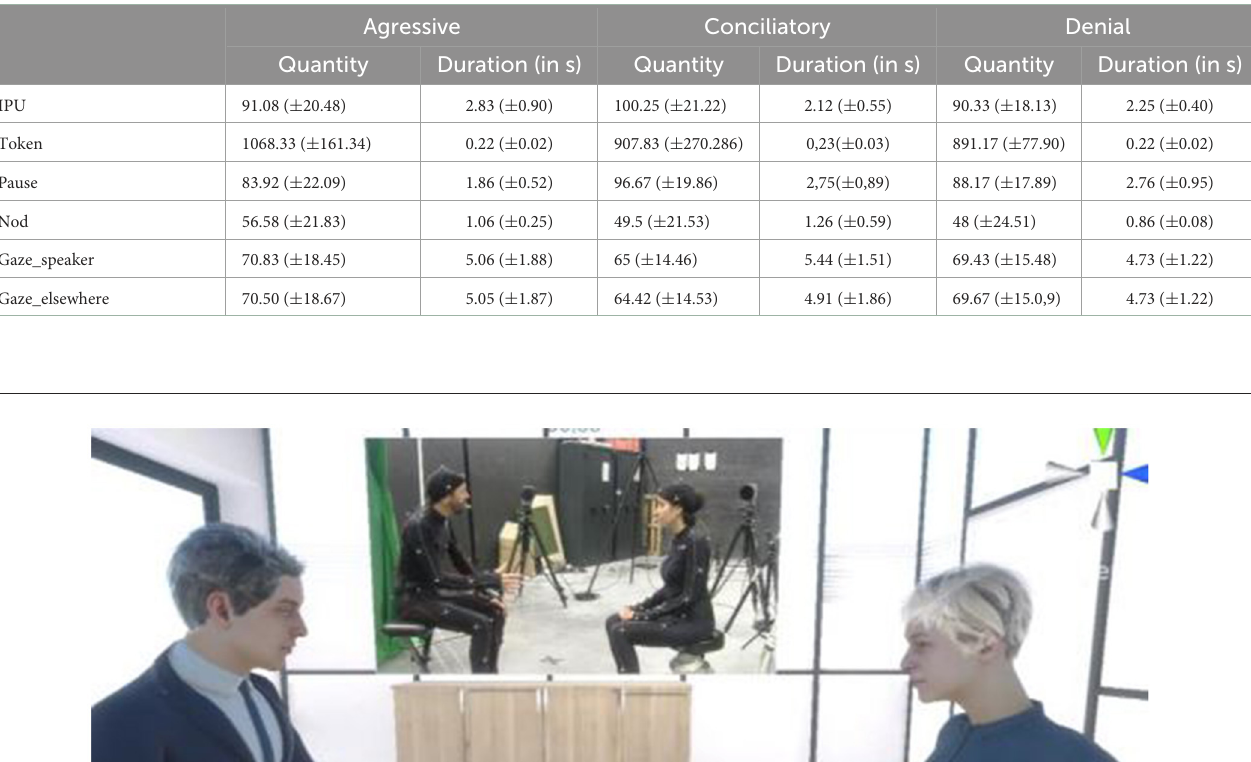
TABLE 4 Descriptive statistics on the behavior of the actors depending on the attitudes.